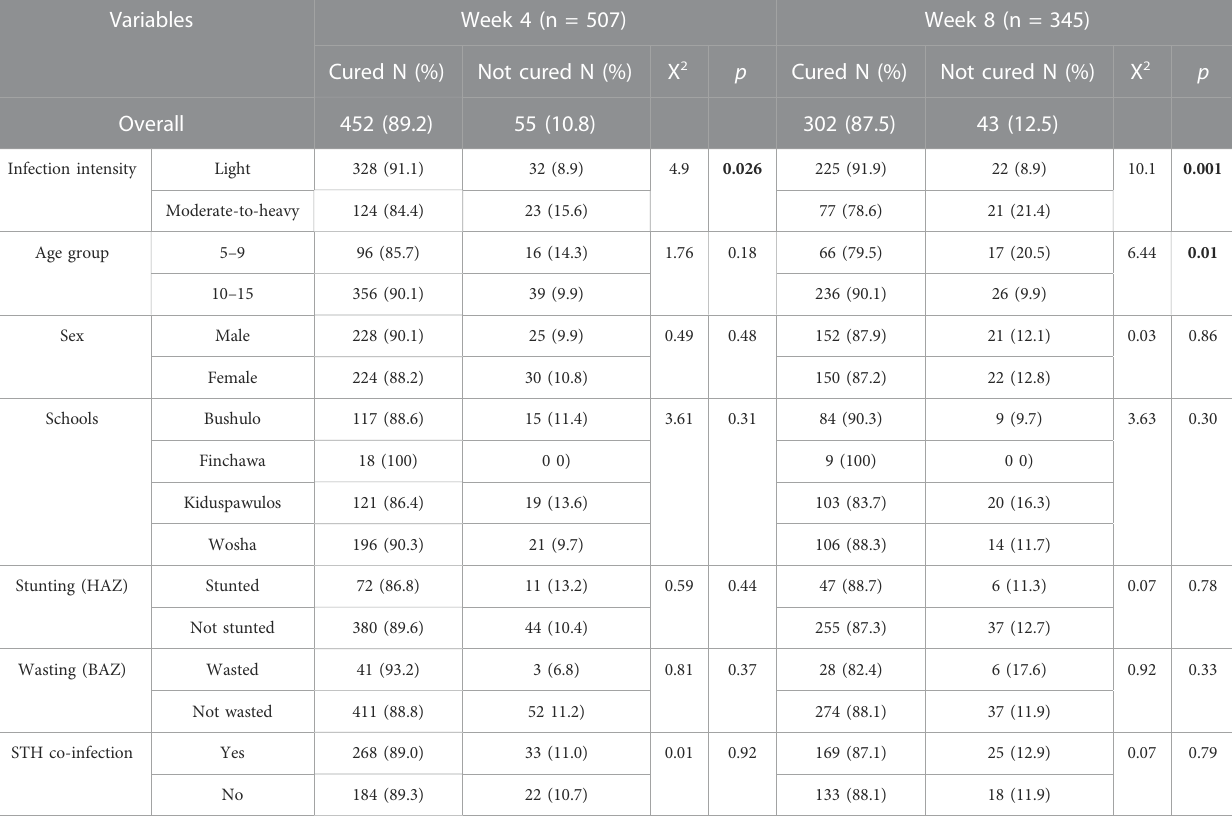
TABLE 2 Cure rate and associated factors at week four and week eight of